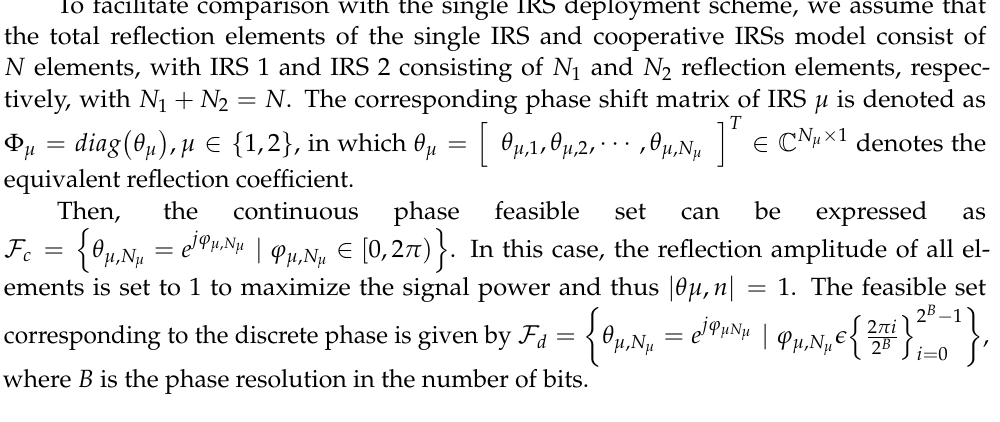
Figure 1. The cooperative double IRS-assisted multi-user MISO downlink communication system.